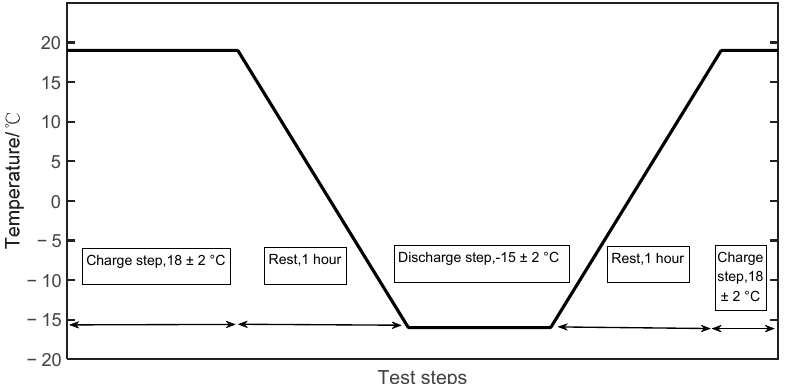
Figure 7. The five temperature conditions loaded at five steps.